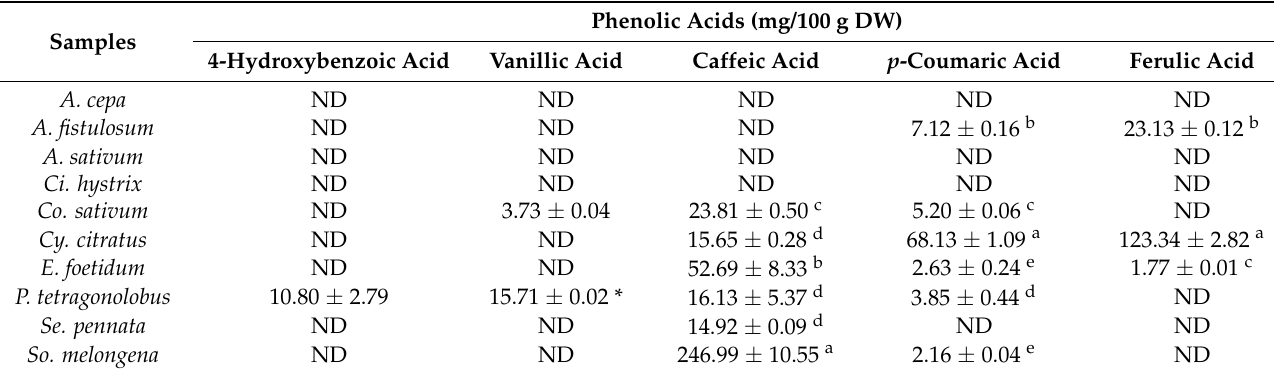
Table 2. Profiles and quantification of phenolic acids in the plant samples.